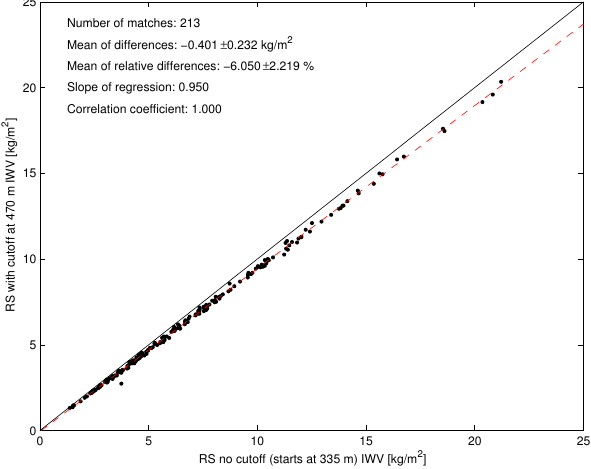
Fig. 3. Scatterplot of radiosonde IWV calculated with a lower inte- gration altitude limit of 470m versus IWV calculated for the entire radiosonde profile, which starts at an altitude of 335m. Both “mea- surements” here are based on the same radiosonde data, only in one case the lowest part of the profile is